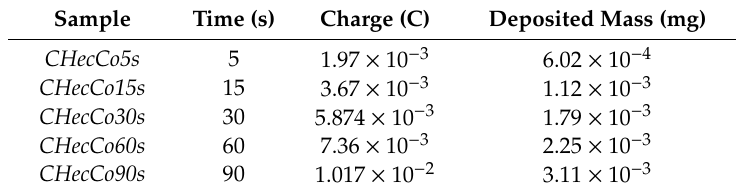
Table 1. Deposited charge related to di ff erent Co deposition time and associated deposited mass per